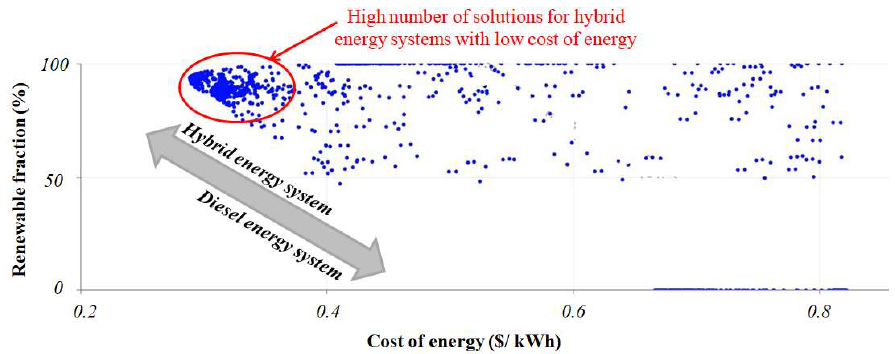
Figure 21. Optimization plot between renewable fraction and cost of energy with project lifetime of 25 years.